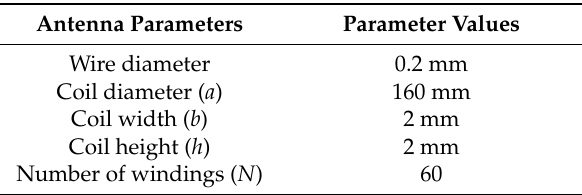
Table 4. The design parameters of the circular coil